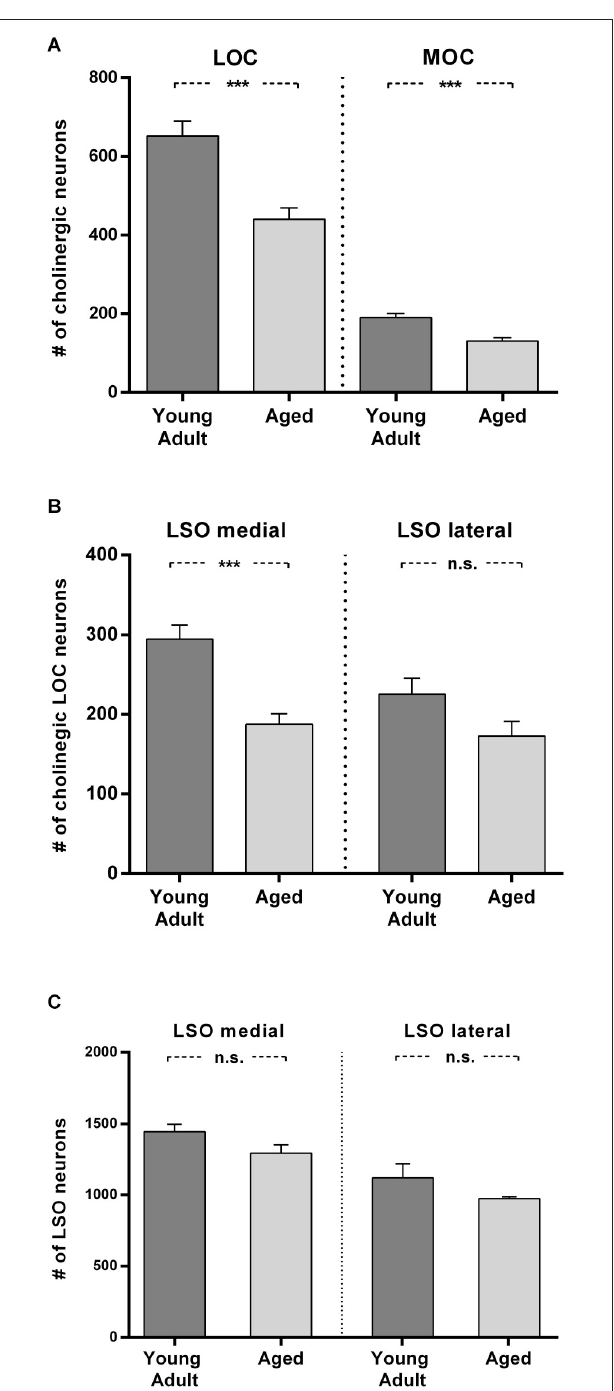
FIGURE 6 | Loss of olivocochlear (A,B) and LSO neurons in general (C) in aged compared to young adult animals . (A) The mean number of LOC and MOC neurons in one hemisphere is represented for young adult and aged animals. The decrease in OC numbers in aged animals relative to young adult animals is significant in LOC and MOC neurons (LOC: 24%: t = 4.436; df = 18; p < 0.001); MOC: 31%, t = 4.357; df = 18; p < 0.001). (B) LOC neuron numbers in medial and lateral part of LSO in young adult (